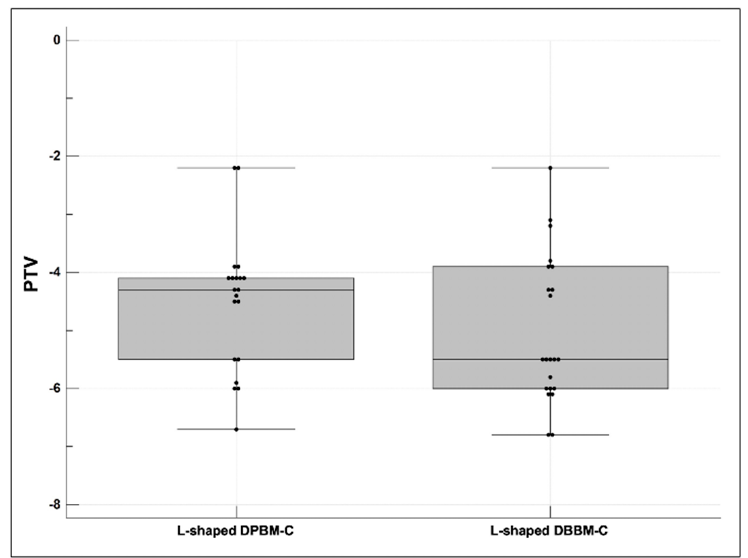
Figure 5. Comparison of the periotest values (PTVs) after re-entry surgery. The PTVs were expressed using box and whisker plots, and they were insignificantly different in the compared groups ( p > 0.05).